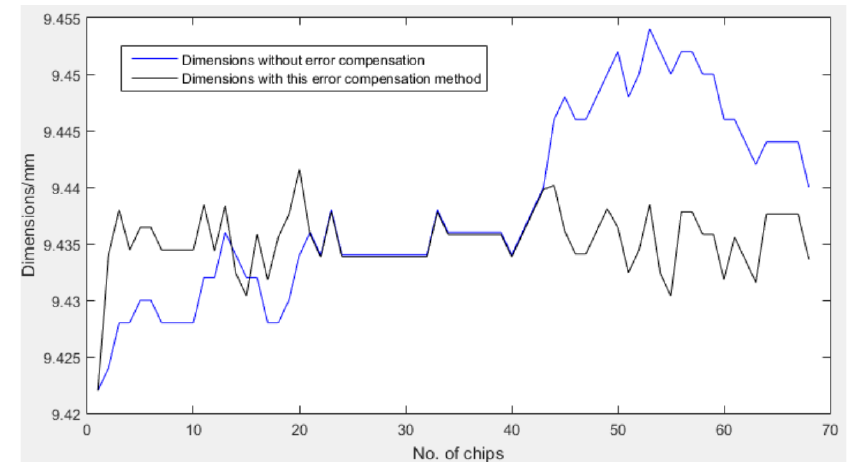
Figure 11. Dimensional variation before and after error compensation.